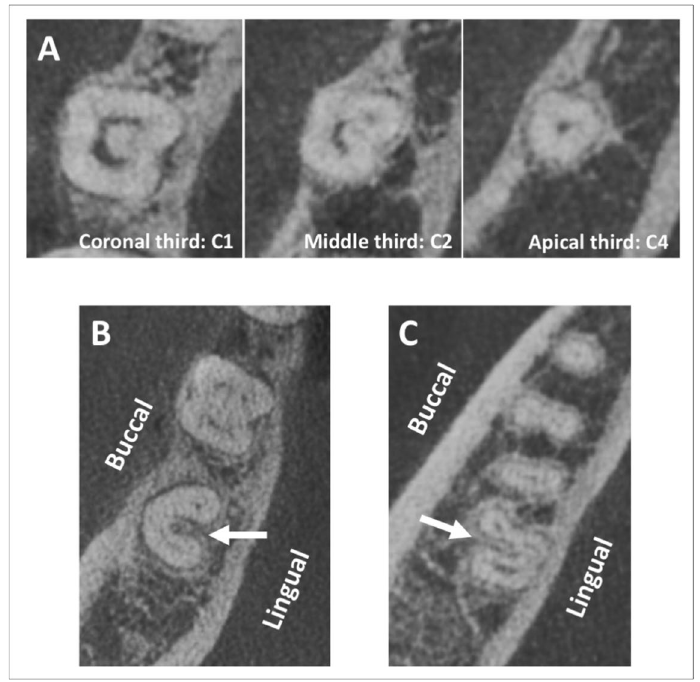
Figure 4. ( A ) axial cross section of mandibular molar showing the changes in the C-Shaped configuration along the root length; at the coronal third the canal started as C1, then changed into C2 at the middle third and finally ended as C4 at the apical third. ( B ) axial cross section of a mandibular second molar showing a lingual location of the groove, while ( C ) is showing the buccal location of the groove.